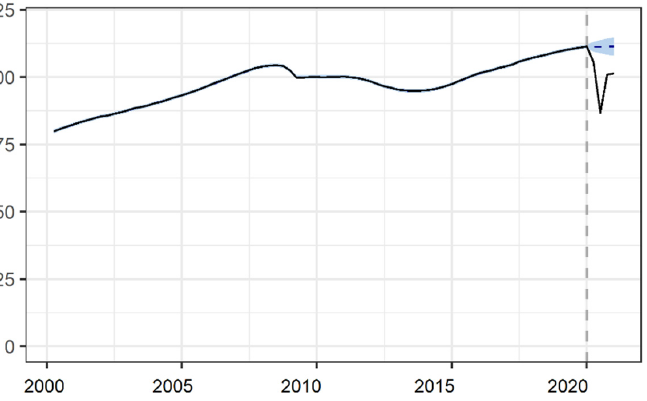
Figure 2. Impact of the COVID-19 crisis on the gross domestic product volume index in Spain. Table 1. Bayesian structural time series model results for gross domestic product volume index: relative cumulative effect (95% Bayesian credible